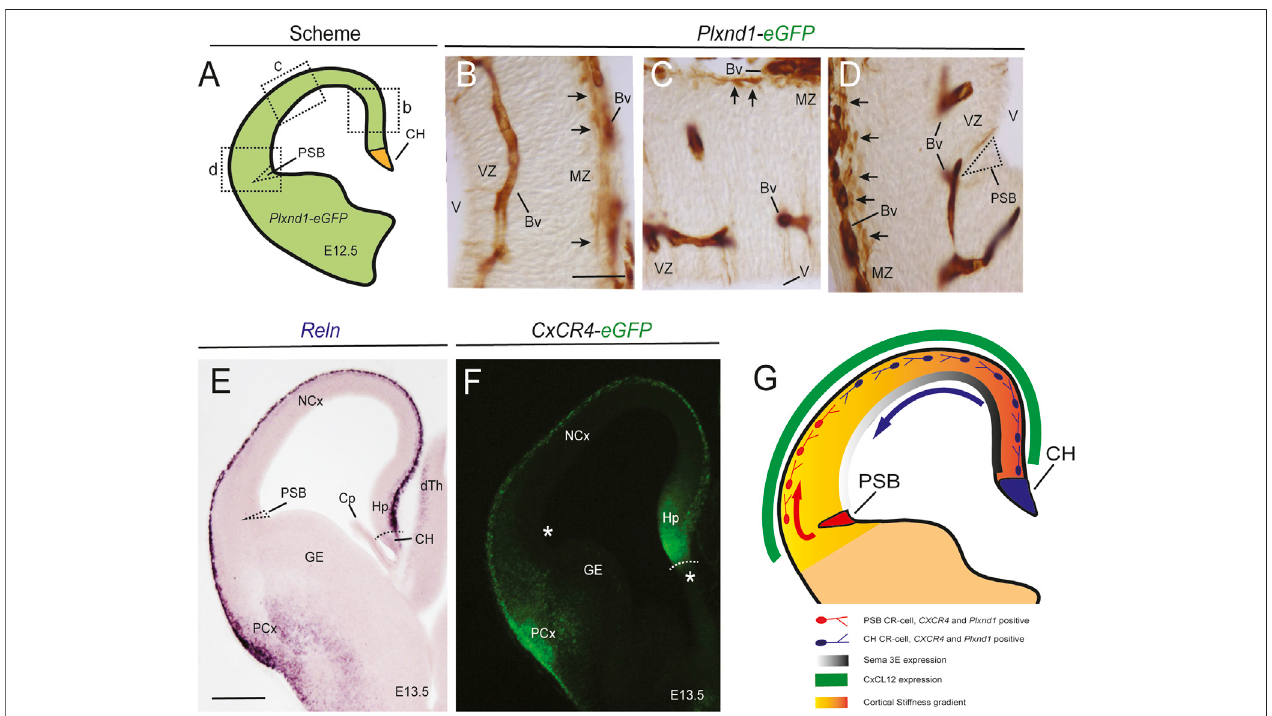
FIGURE 5 | Mechanical and chemical cues modulate the migration of PSB- and CH-derived CR cells. Data presented in this fi gure illustrate some of the cues involvedintheCR-cellmigration (A – D) Scheme (A) andeGFPimmunostainingusingimmunoperoxidasemethodsofPlexinD1intransgenic Plxnd1 -eGFPmice.PlexinD1 is present in blood vessels as well as in CR cells in the complete marginal zone (arrows in B-D). The speci fi c location of the PSB is labelled in (D) and illustrates the absence of PlexinD1 in this region. This demonstrates that its expression is postmitotic and linked to its position in marginal zone (E,F) Reln in situ hybridization (E) and eGFP fl uorescence in CxCR4-eGFP mice (F) , respectively, illustrating their distribution in the developing pallium. Asterisks and dashed regions in (F) illustrate the absence of Reln and CXCR4 in the proliferative regions, especially the PSB (G) Scheme summarizing the results observed in our studies (see Discussion for